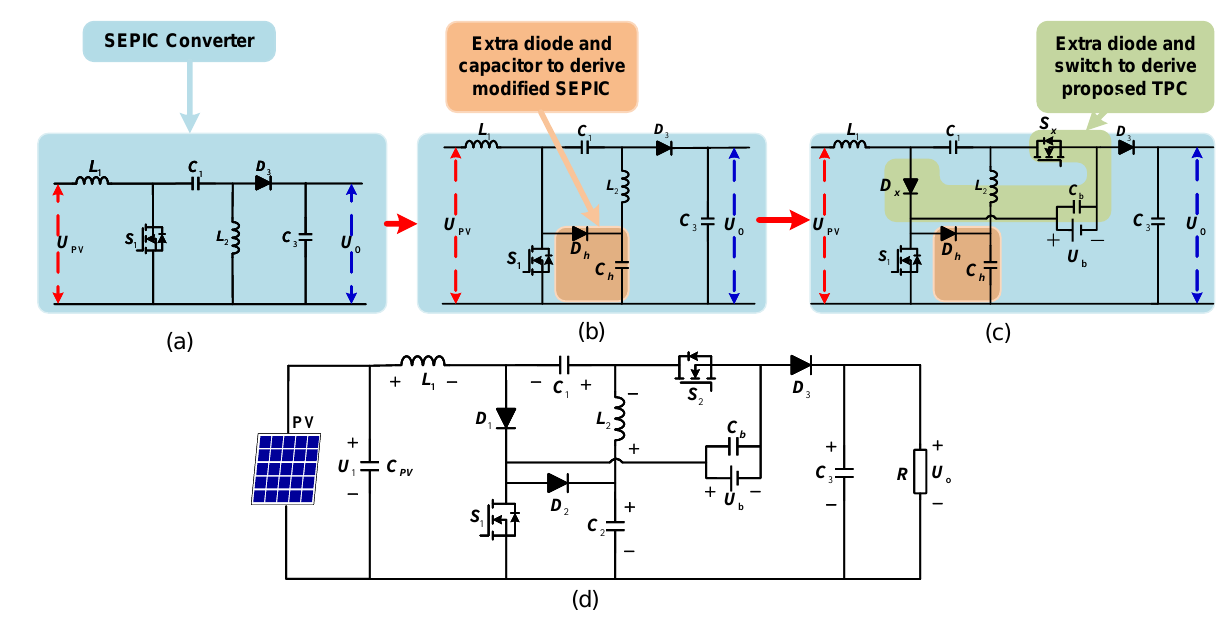
Figure 2. Topology derivation: ( a ) conventional SEPIC converter, ( b ) modified SEPIC converter, ( c ) proposed converter topology, and ( d ) redrawing of proposed